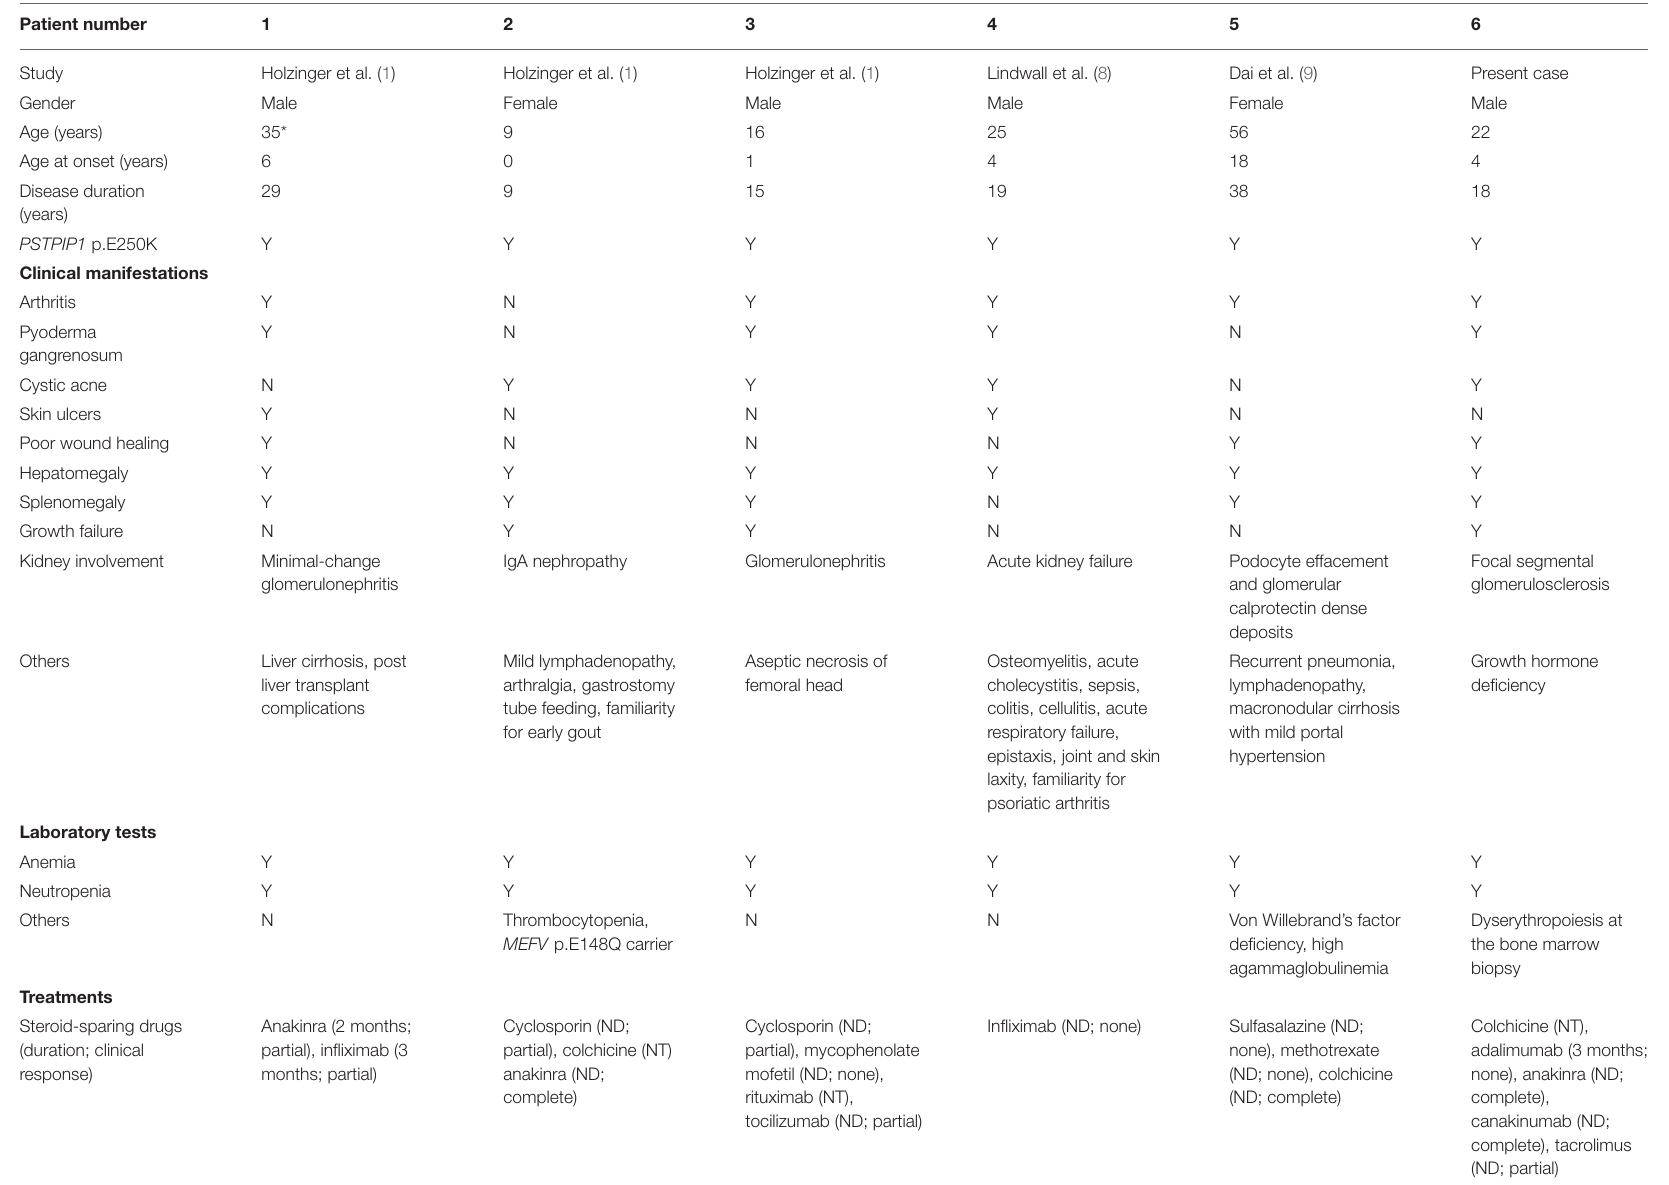
TABLE 2 | Reported cases of kidney involvement in PSTPIP1-associated inflammatory